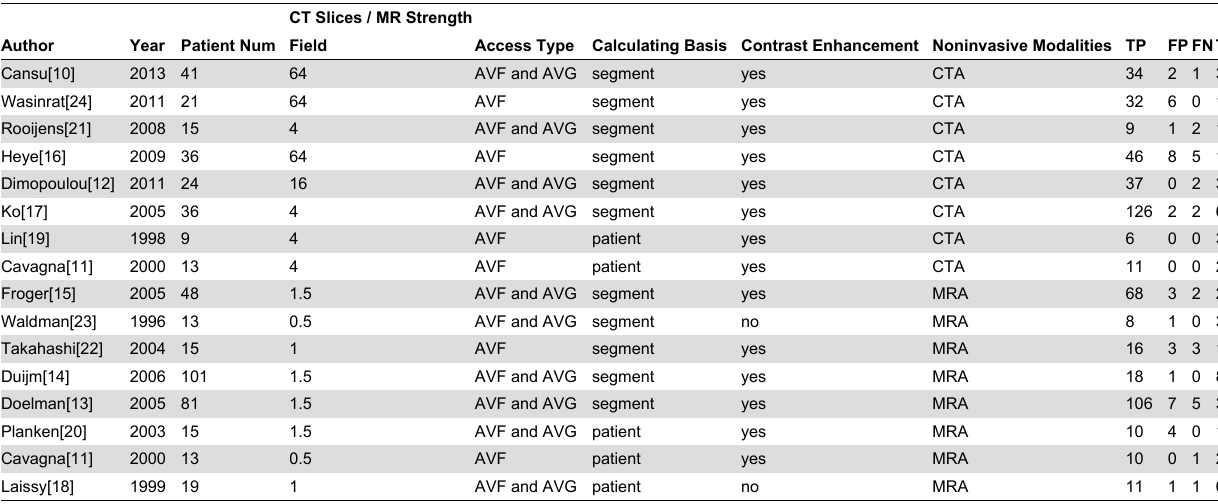
Table 1. Studies included in the